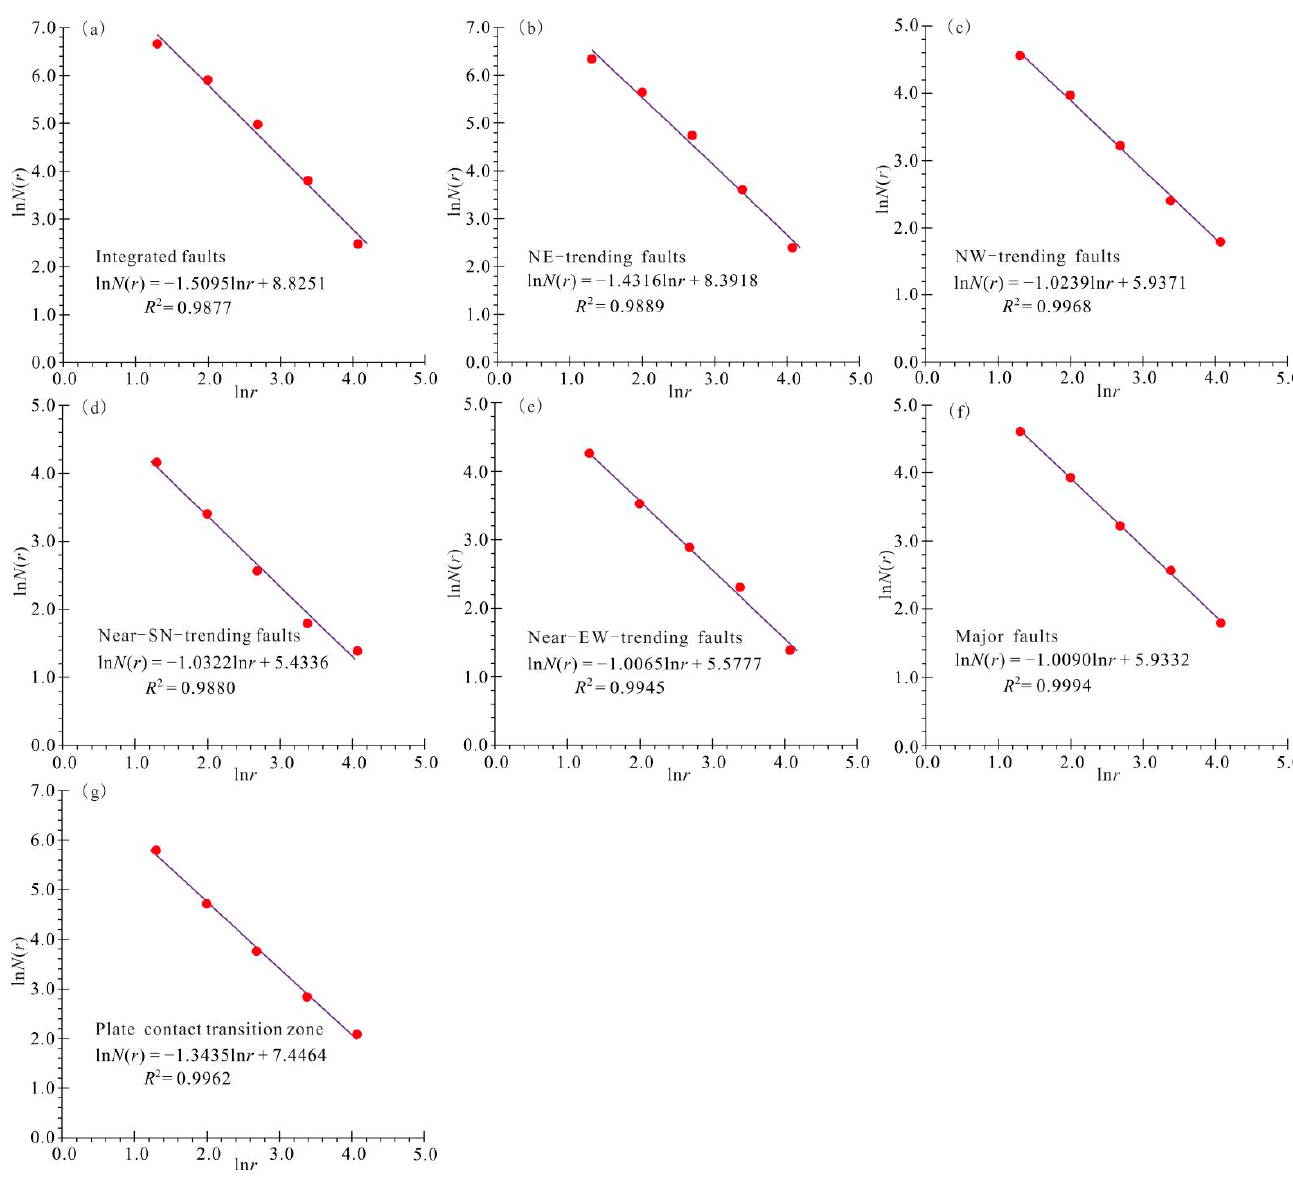
Figure 3. Linear fitting diagrams of the capacity dimension (CPD) calculation for faults in the eastern Guizhou Pb–Zn metallogenic belt (EGMB). The ln r versus ln N ( r ) plots of CPD data for ( a ) Integrated faults; ( b ) NE-trending faults; ( c ) NW-trending faults; ( d ) Near-SN-trending faults; ( e ) Near-EW-trending faults; ( f ) Major faults; and ( g ) Plate contact transition zone, showing their linear regression parameters.